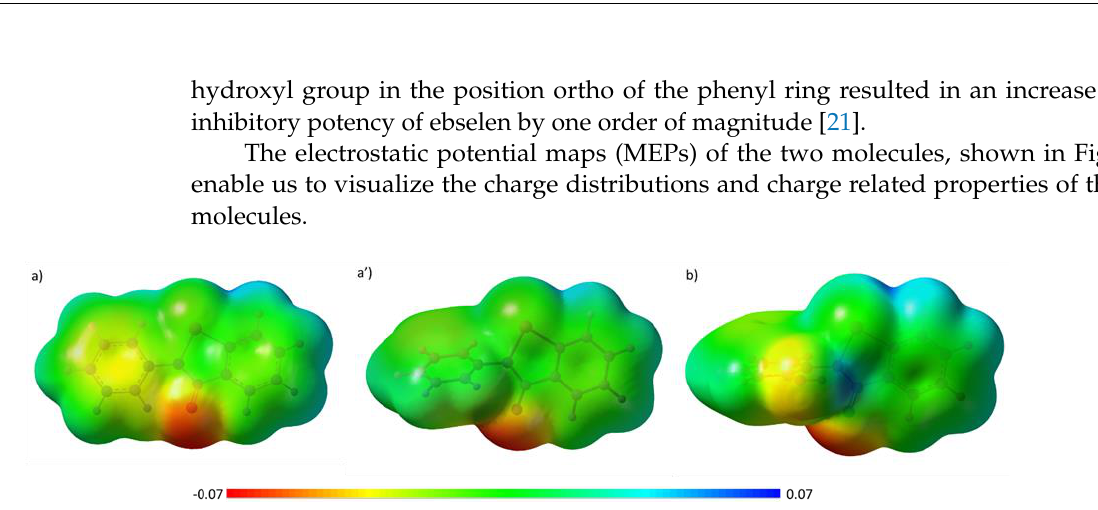
Figure 2. Molecular electrostatic potential (MEP) of: ( a ) planar EBS; ( a’ ) nonplanar EBS and ( b ) EBS-OH geometries optimized at B3LYP/6-31+G level of theory.